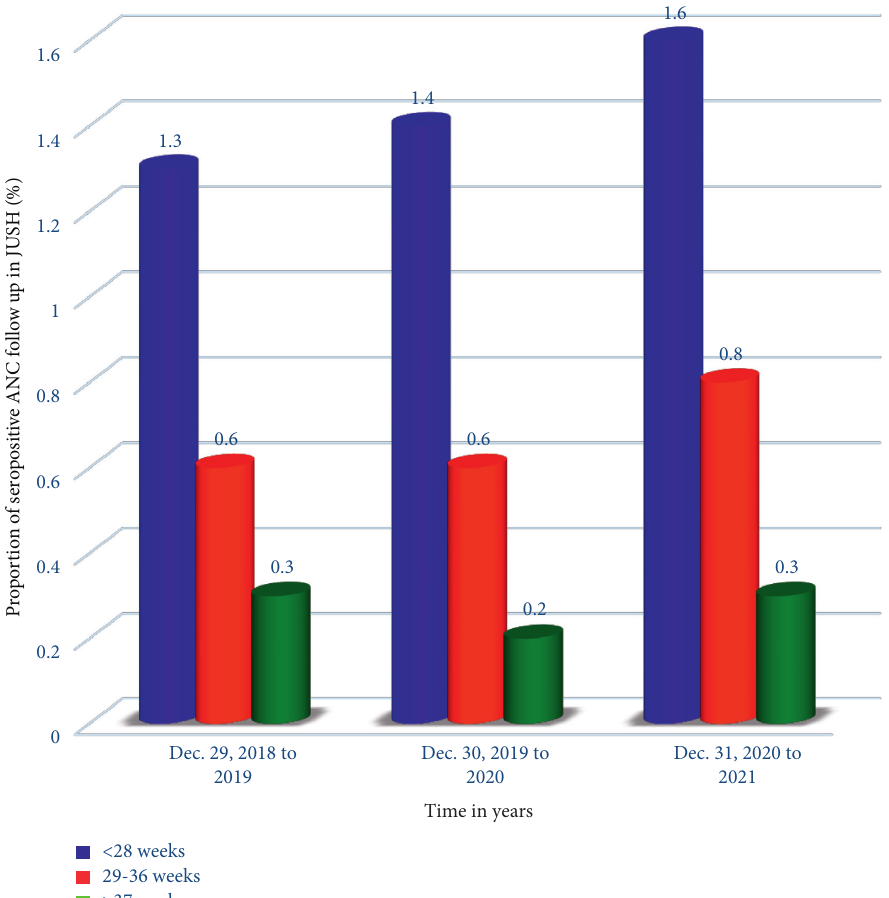
Figure 3: The seropositivity of HIV by gestational weeks and year of study among pregnant mothers on ANC follow-up at JUSH.